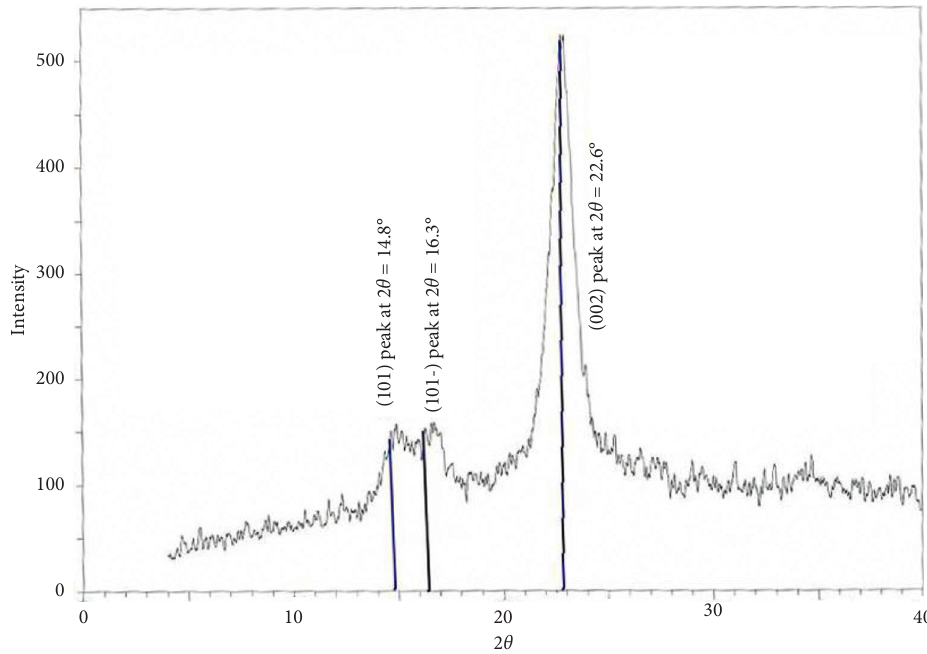
Figure 5: X-ray diffractograms of